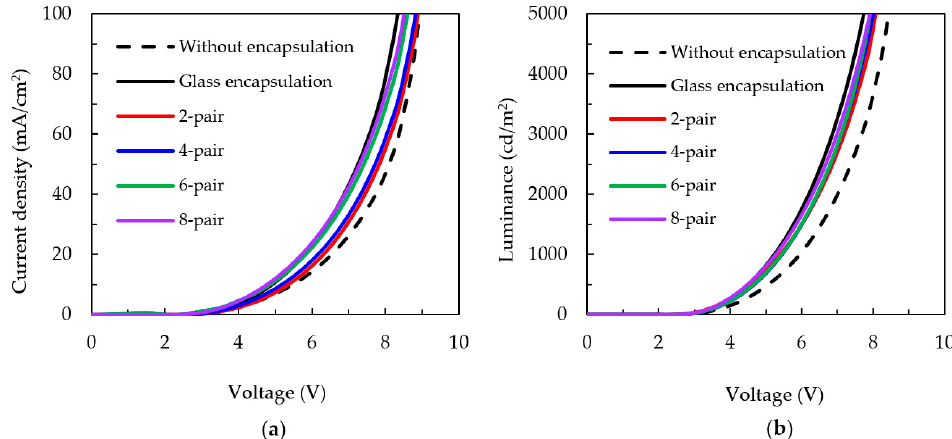
Figure 3. ( a ) Current density–voltage and ( b ) luminance–voltage characteristics of organic light-emitting diodes (OLED) devices encapsulated by different pair numbers of SiO x /SiC x H y stacks. diodes (OLED) devices encapsulated by di